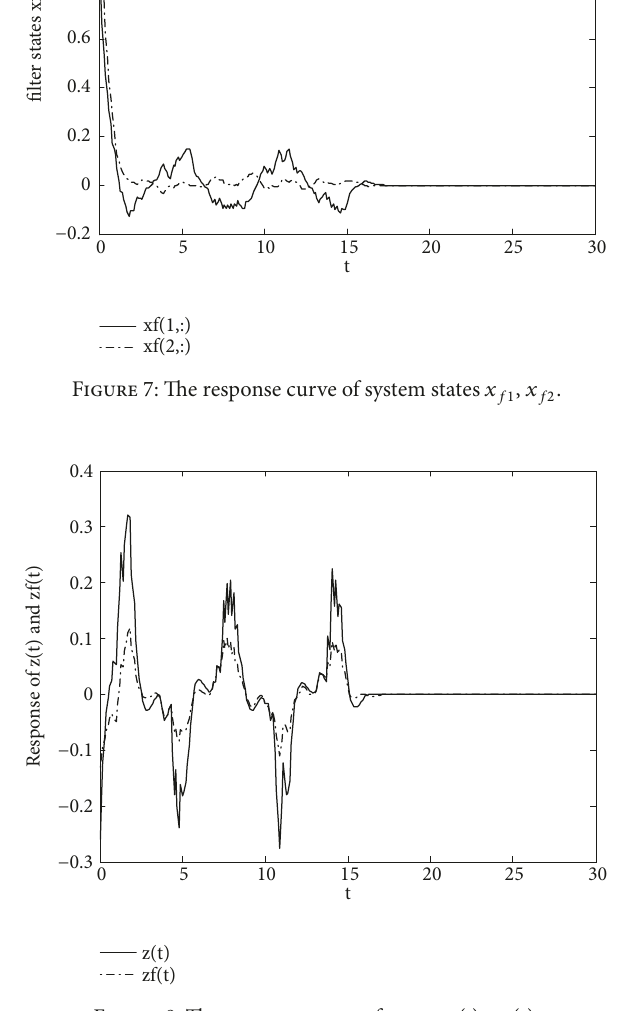
Figure 8: The response curve of vector 𝑧( t ) , 𝑧 𝑓 ( t ) .